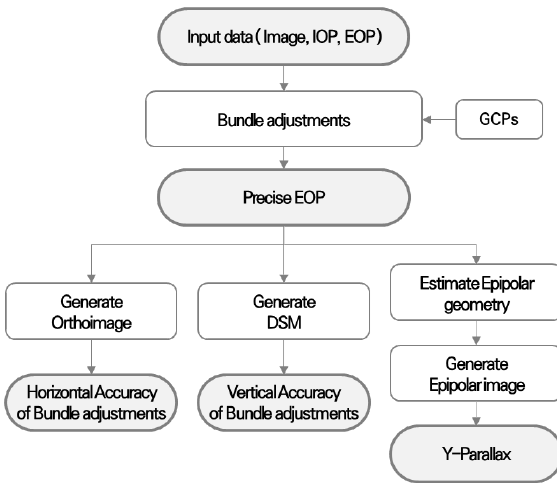
Figure 7. Overlap between images analysis process